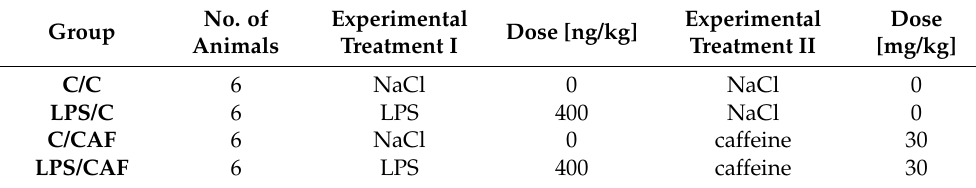
Table 3. Experiment organization